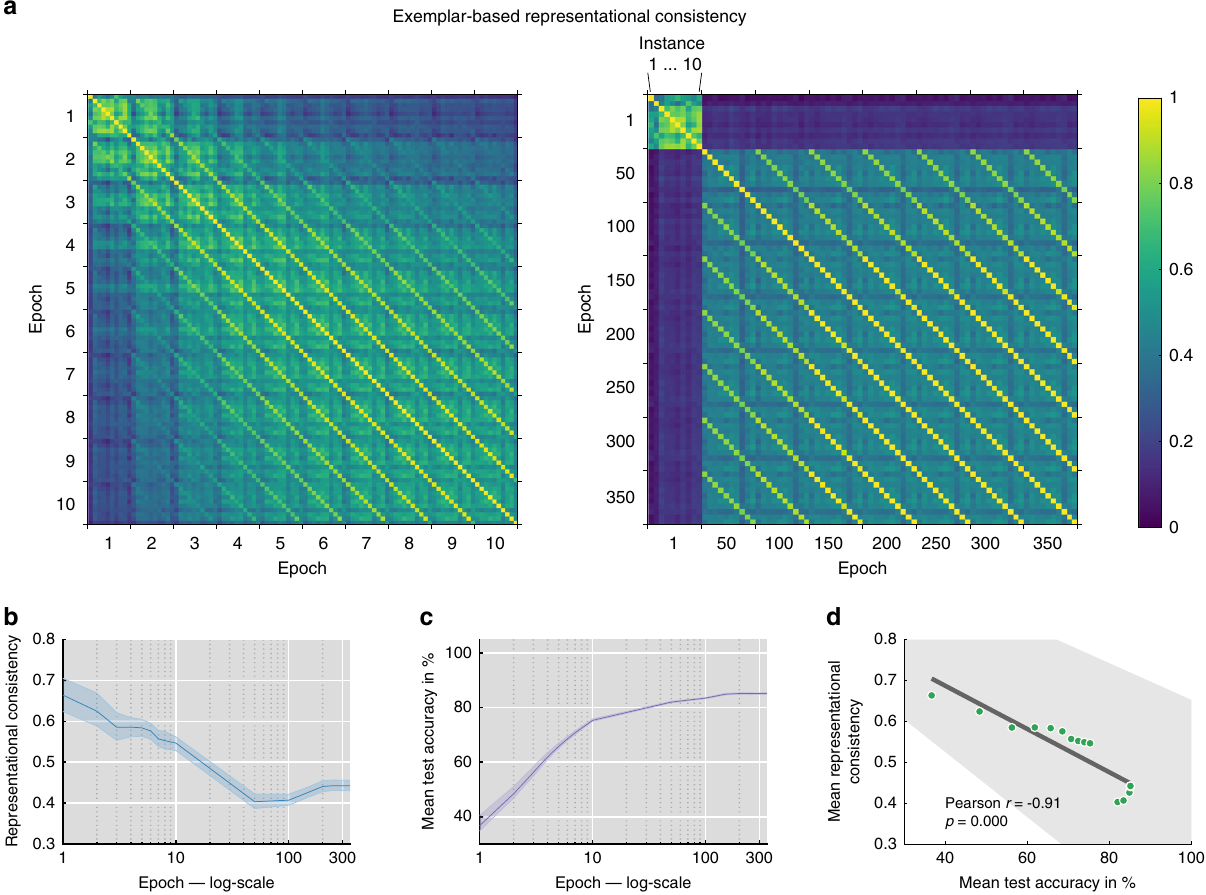
Fig. 9 Final-layer representational consistency (exemplar-based) across training epochs. a Comparing representational consistency across early epochs [1 to 10] (left) and throughout all training epochs [1 to 350 in steps of 50] (right). Lines parallel to the main diagonal indicate that network instances remain on their distinct representational trajectory compared to other networks. Average consistency shown across 45 network pairs, derived from 10 network instances. b Representational consistency, computed and averaged across all network pairs (45 pairs total) for each training epoch, demonstrates increasing individual differences with training (shown with 95% CI). c Test performance across training (average top-1 accuracy across 10 network instances with 95% CI). d Representational consistency and test performance exhibit a strong negative relationship (Pearson r = − 0.91, p < 0.001; robust correlation) indicating that task training enhances individual differences (dots represent network training epochs, error bar indicates 95%